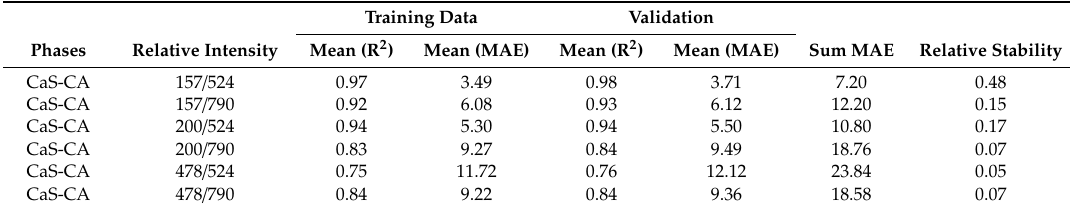
Table 4. Evaluation of the coe ffi cient of determination (R 2 ) and mean absolute error (MAE) for the prediction and validation between the phase content and relative intensity of the Raman peaks and phase content for CaS–CA.